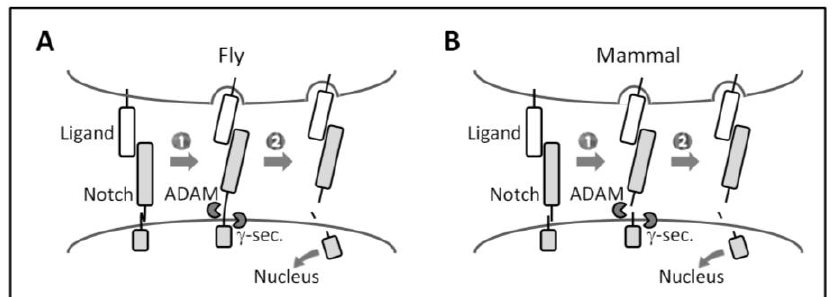
Figure 2. Canonical Notch signaling. ( A and B ) Canonical Notch signaling requires the successive cleavage of Notch by ADAMs and the γ -secretase complex. (1) Upon ligand binding, endocytosis in ligand-expressing cells is proposed to generate a pulling force that induces ( A ) conformational changes in d Notch ECD or ( B ) the dissociation of heterodimerized mammalian Notch ECD [24,65–67]; (2) This allows ADAMs to access the cleavage site of Notch ECD remaining on the membrane [24]. After γ-secretase processing, the released Notch ICD induces transcription of target genes.